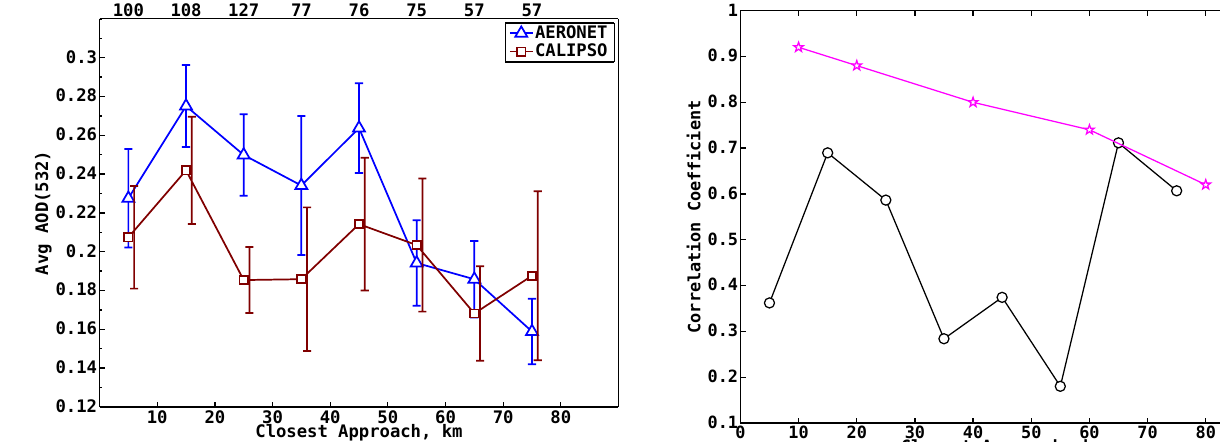
Fig. 4. Absolute bias with 67% and 95% confidence intervals for 515 overpasses with a single CALIPSO aerosol subtype through- out the column. CALIPSO aerosol subtypes include polluted dust (PDu), dust (Dst), polluted continental (PCo), marine (Mrn), smoke (Smo), and clean continental (CCo). Number of overpasses per sub- type are indicated by the top row of numbers.